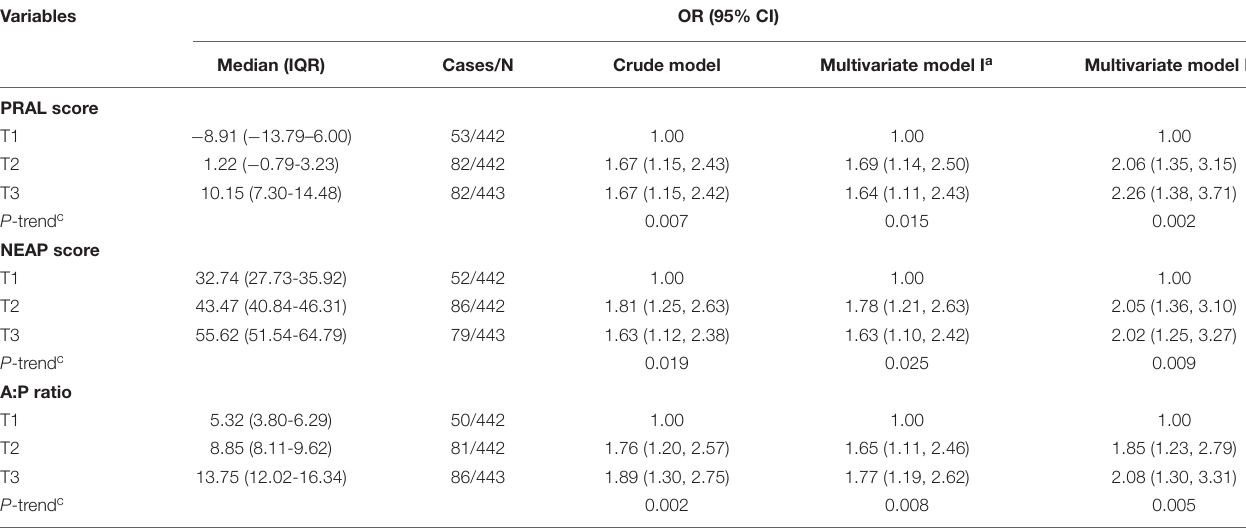
TABLE 3 | Associations between maternal dietary acid load and risk of GDM.